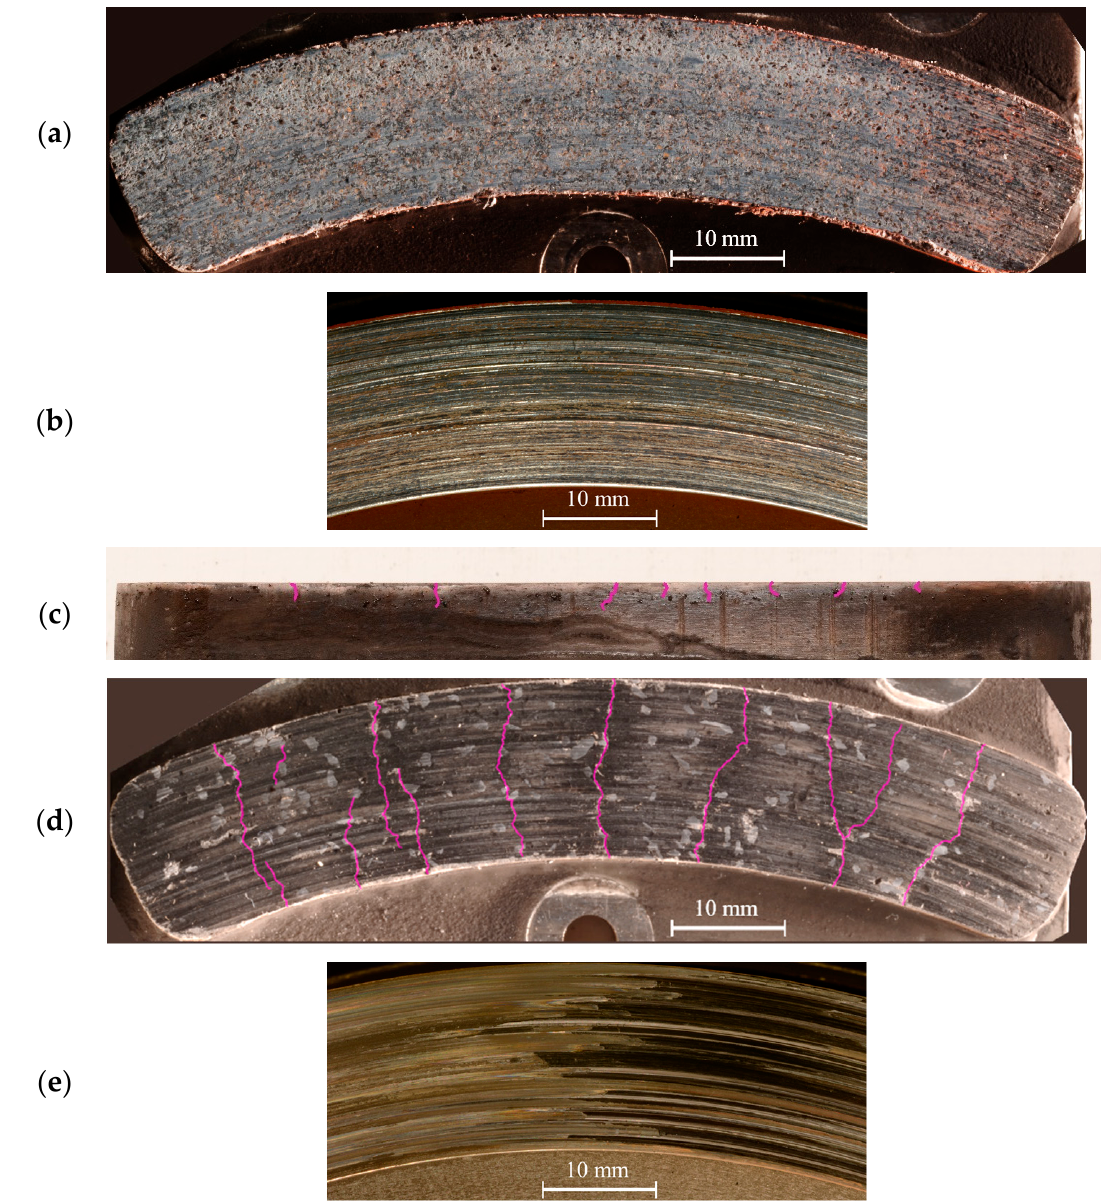
Figure 9. Worn surfaces: ( a ) Surface of an LS pad; ( b ) corresponding GCI disc; ( c ) sideview of a NAO pad; ( d ) surface of the NAO pad; ( e ) corresponding GCI disc. The purple lines highlight the paths of cracks visible to the naked eye.